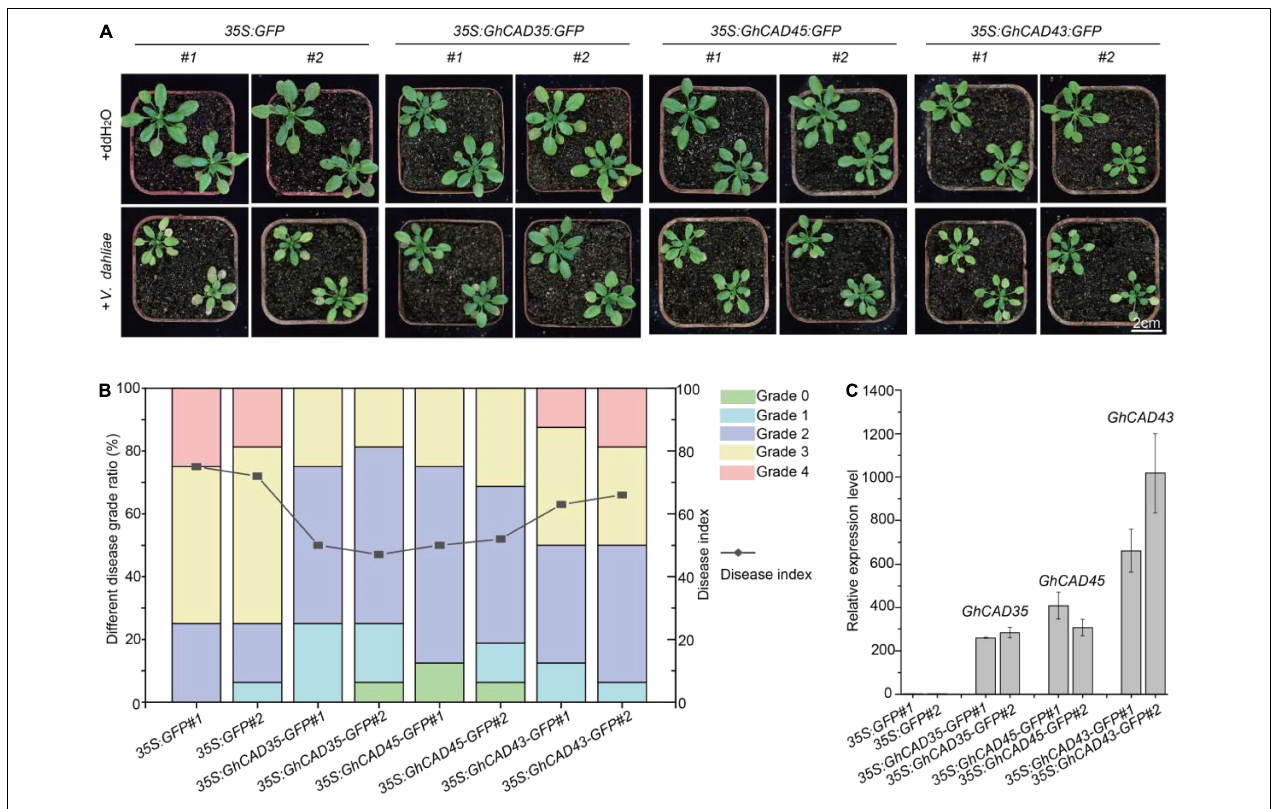
FIGURE 9 | Heterogeneously expressing of GhCAD35, GhCAD45 , and GhCAD43 in Arabidopsis enhanced resistance to V . dahliae infection. (A) Phenotypes of the transgenic Arabidopsis plants overexpressing GhCAD35 , GhCAD45 , or GhCAD43 at 14 days post-infection (dpi) by V. dahliae . (B) Ratio of different diseased grades and disease index for GhCAD35 , GhCAD45 , and GhCAD43 overexpressing transgenic Arabidopsis plants at 14 dpi by V. dahliae. Two independent Arabidopsis transgenic lines of 35S:GhCAD35-GFP , 35S:GhCAD45-GFP , and 35S:GhCAD43-GFP were used for V. dahliae infection. 35S:GFP Arabidopsis transgenic plants were used as control. Two-weeks-old Arabidopsis transgenic plants were inoculated with V. dahliae via root-dipping method; 16 plants for each line were used. (C) The expression level of GhCAD35, GhCAD45 , and GhCAD43 in the corresponding Arabidopsis transgenic plants determined by